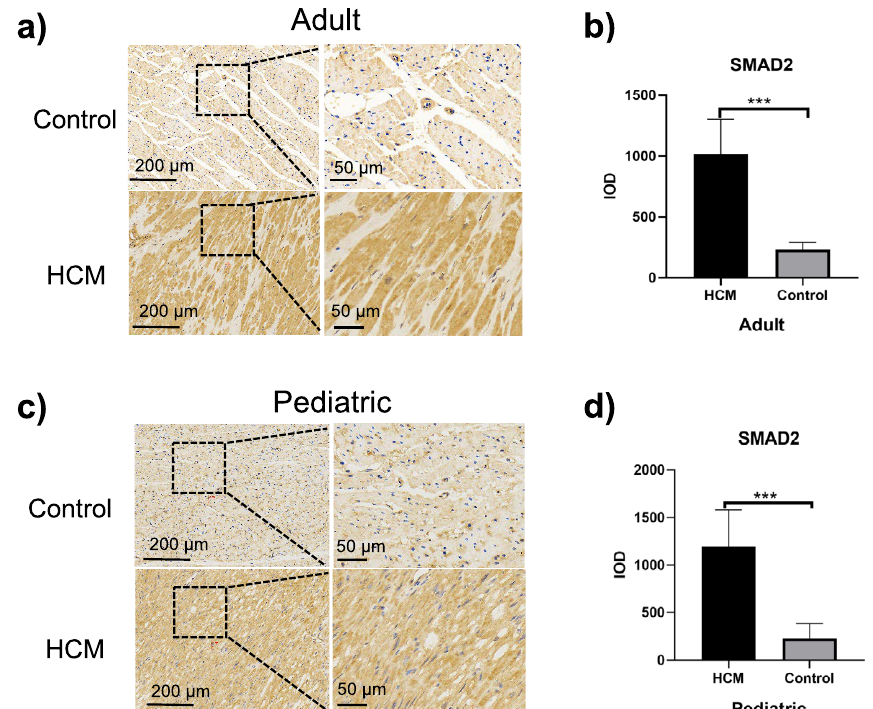
Figure 2. Immunohistochemical analysis of SMAD2 expression in ventricular septal myocardial tissue from patients with HOCM. ( a ) Representative images of immunohistochemical staining of SMAD2 in ventricular septal myocardial tissue from the control and adult HOCM patients. Scale bars, 200 μm and 50 μm (enlarged views of boxed areas). b. Quantification of SMAD2 expression level in ventricular septal myocardial tissue from the control and adult HOCM patients. Data are mean ± SEM, *** p < 0.001. c. Representative images of immunohistochemical staining of SMAD2 in ventricular septal myocardial tissue from the control and pediatric HOCM patients. Scale bars, 200 μm and 50 μm (enlarged views of boxed areas). d. Quantification of SMAD2 expression level in ventricular septal myocardial tissue from the control and pediatric HOCM patients. Data are mean ± SEM, *** p <